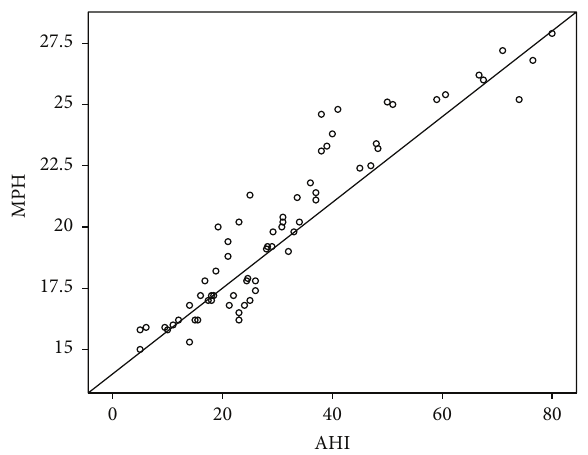
Diagonal segments are produced by ties Figure 6: ROC curve for MP-H; area: